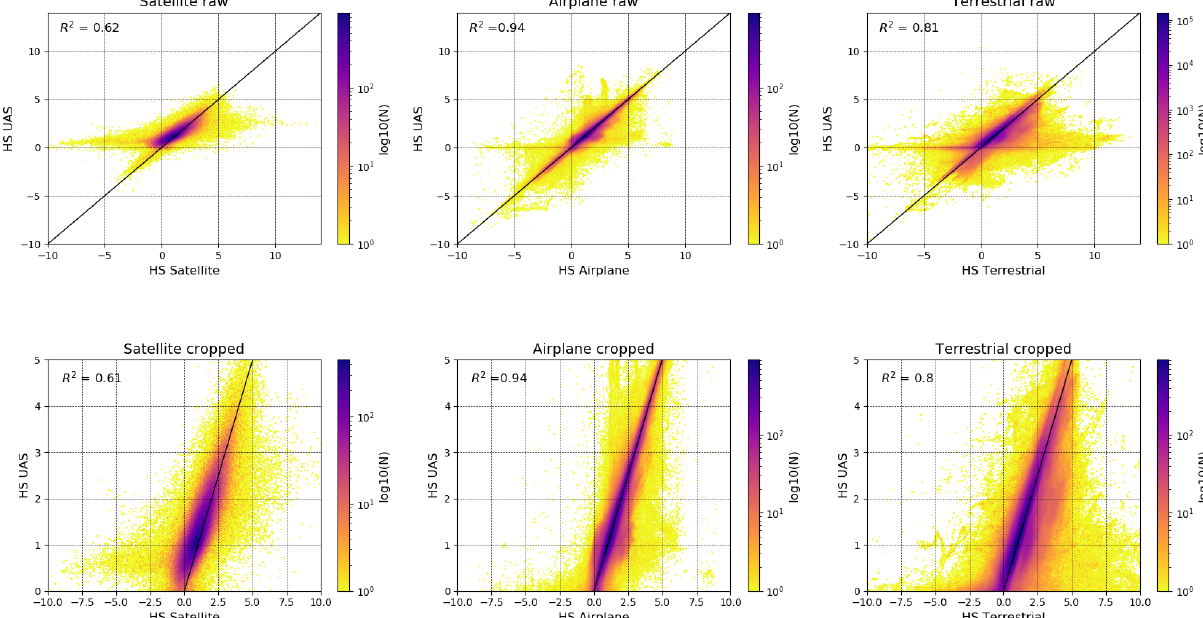
Figure 9. Scatter plot of comparison 2: the three upper scatter plots show the platform snow depth on the x axis and the corresponding UAS snow depth on the y axis. For the lower scatter plots, only the snow depths of the UAS snow depth map in the range of 0 to 5m were considered and compared to the corresponding values from each platform; 0.8% of the satellite data, 0.8% of the airplane data and 1.9% of the terrestrial data were removed. The scatter plots have a logarithmic scale, which is shown on the right side with a plasma colour bar. R 2 is given for each scatter plot.